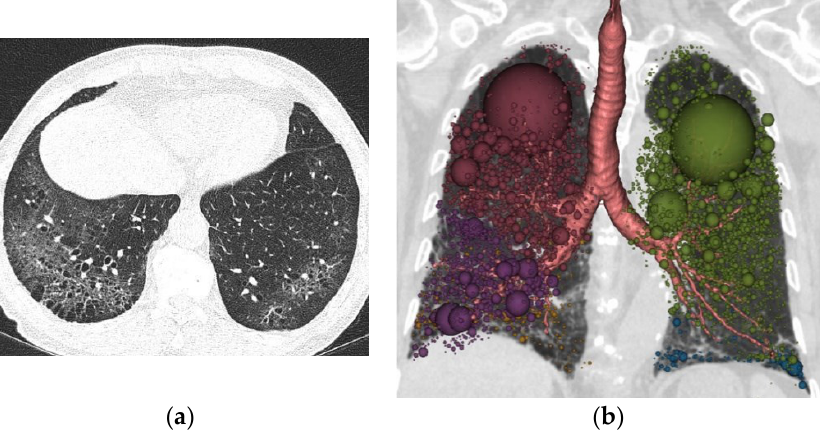
Figure 4. ( a ) 82-year-old man who belonged to the heavy smoking group. A. Chest CT shows ground-glass opacity with honeycomb in predominantly subpleural area of posterobasal segment, both lower lobe; ( b ) Quantitative data from chest CT shows upper lobe predominant emphysema with a quantified low attenuation area (LAA I-950 : 10.97%) and Pi10 (4.03 mm 2 ).